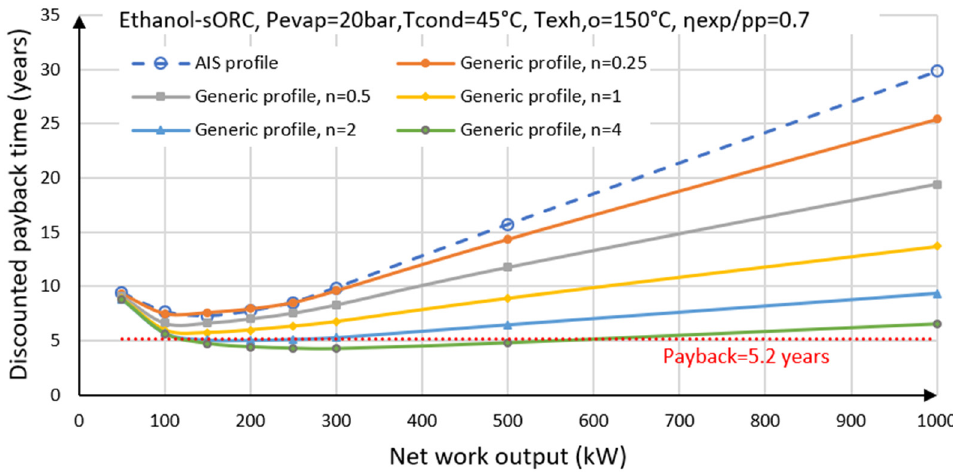
Figure 19. Payback time for ethanol-sORC with different operating profiles.